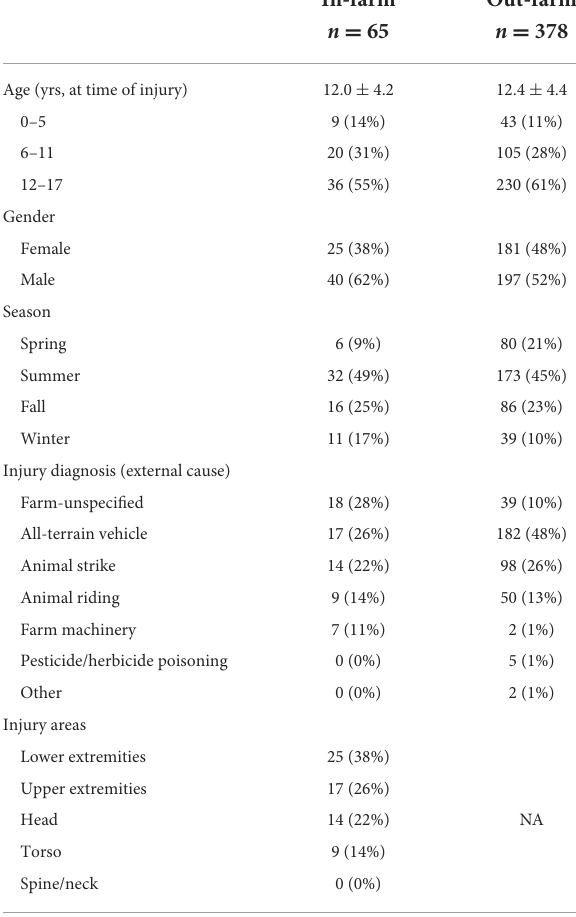
TABLE 2 Features of incident farm-related injuries in north-central Wisconsin children and adolescents in 2017–2021, stratified by those who did vs. did not live on a